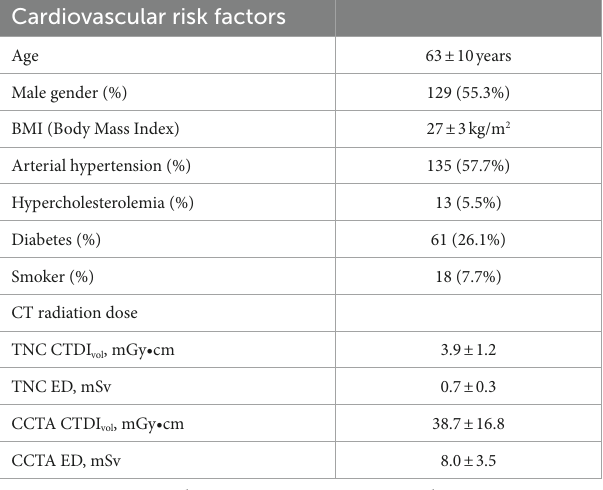
TABLE 1 Baseline characteristics of